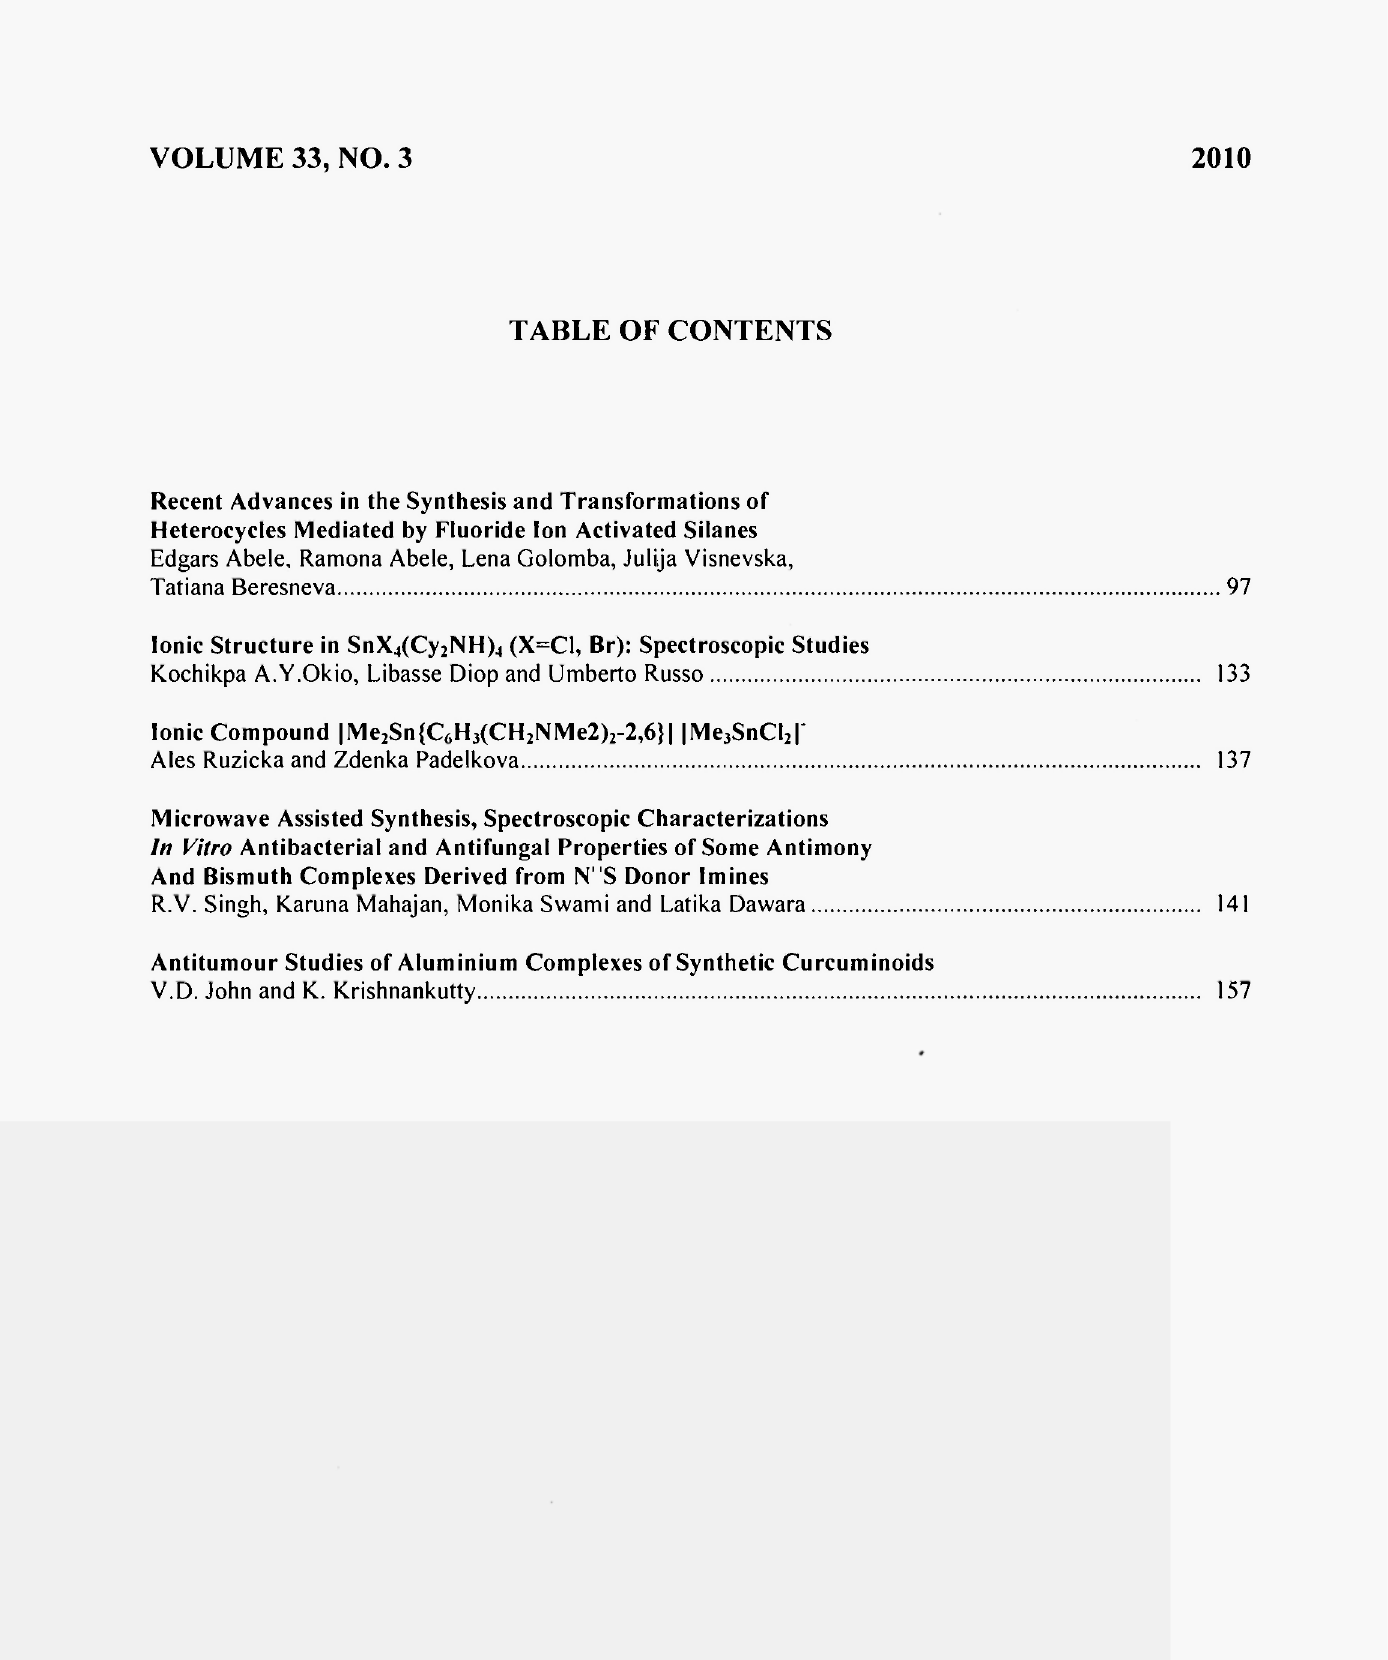
Recent Advances in the Synthesis and Transformations of Heterocycles Mediated by Fluoride Ion Activated Silanes Edgars Abele, Ramona Abele, Lena Golomba, Julija Visnevska, Tatiana Beresneva 97 Ionic Structure in SnX 4 (Cy 2 NH) 4 (X=C1, Br): Spectroscopic Studies Kochikpa A.Y.Okio, Libasse Diop and Umberto Russo